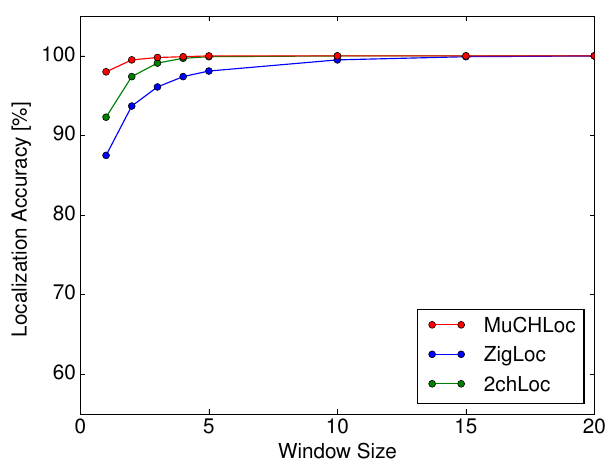
Figure 12. Localization accuracy in a multi-AP environment as a function of window size w